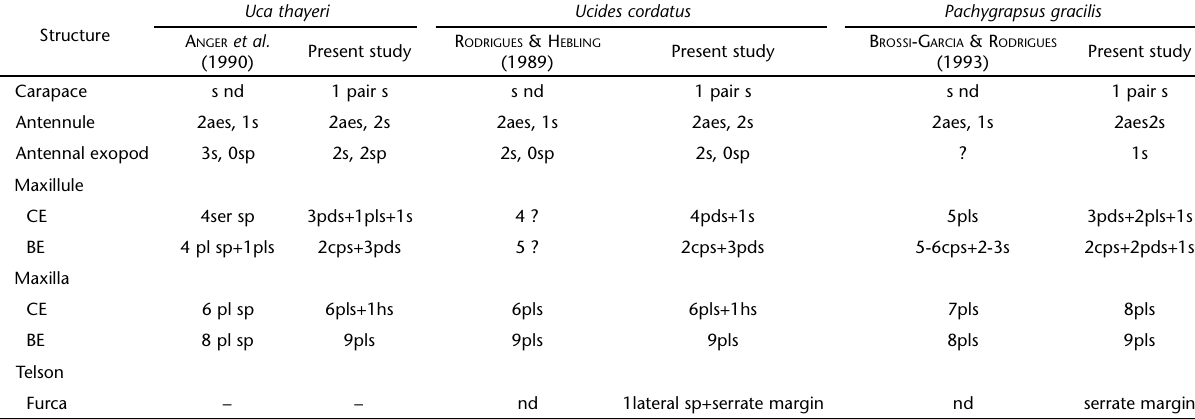
Table VI. Morphological comparison between the present study and previous descriptions of Uca thayeri , Ucides cordatus and Pachygrapsus gracilis .